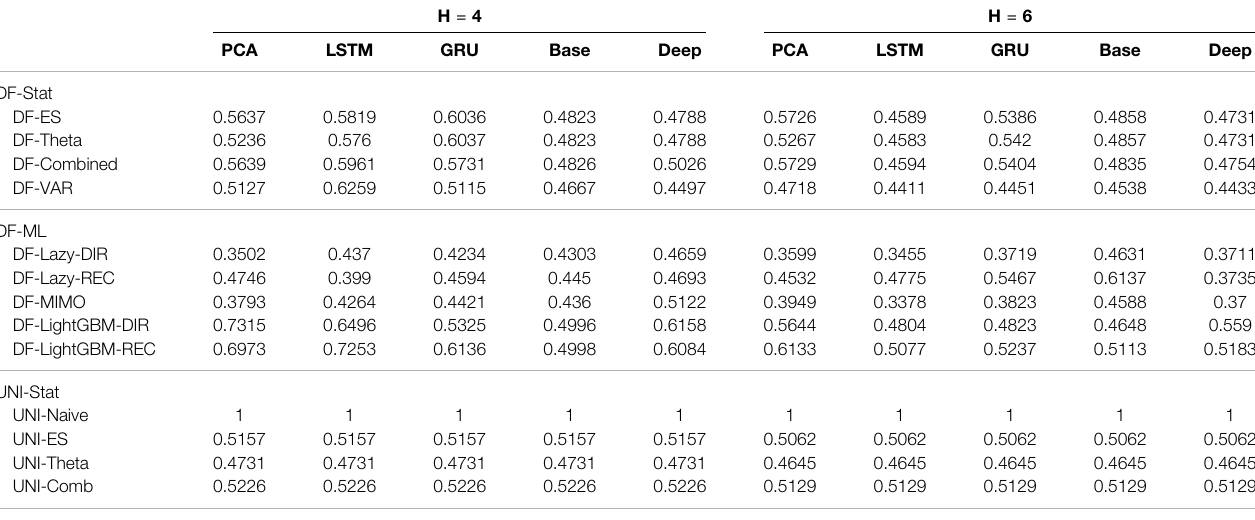
TABLE6| Traf fi cNaiveNormalizedMSEfor H ∈ {4,6}.Thecontentofthecell c ij representsthemodelusingthe j thdimensionalityreductiontechniquewiththe i thforecasting method. The NNMSE for the Naive method is equal to 1. An NNMSE < 1 indicates that the proposed method outperforms the Naive